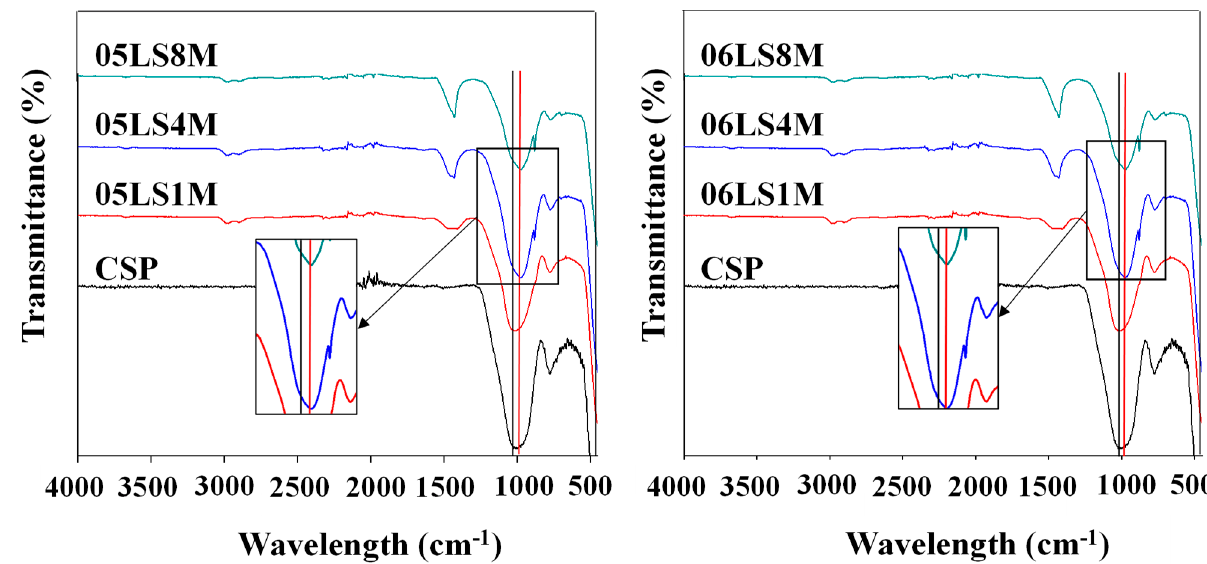
Figure 5. FTIR spectra results for the CSP precursor and the different AAC formulations obtained, depending on the L/S ratios (0.5 and 0.6) and the NaOH concentration.